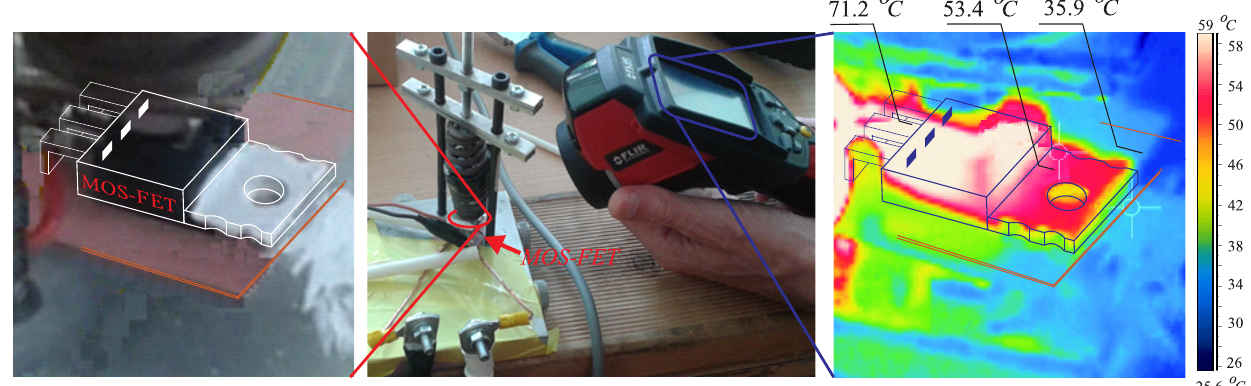
Figure 5. Measurement of R